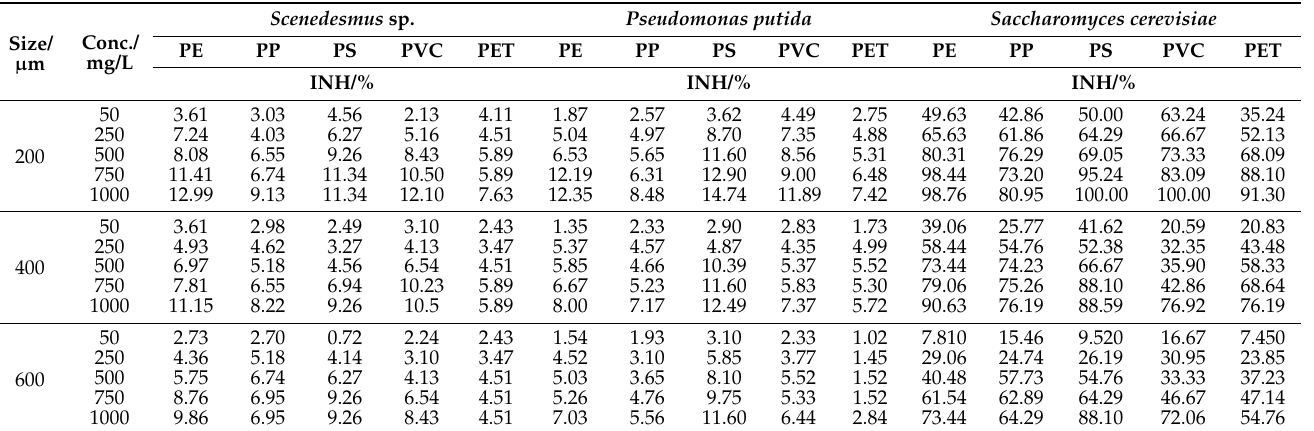
Table 1. Experimentally determined inhibition values (INH) for polyethylene (PE), polypropylene (PP), polystyrene (PS), polyvinyl chloride (PVC), and polyethylene terephthalate (PET) microplastics.